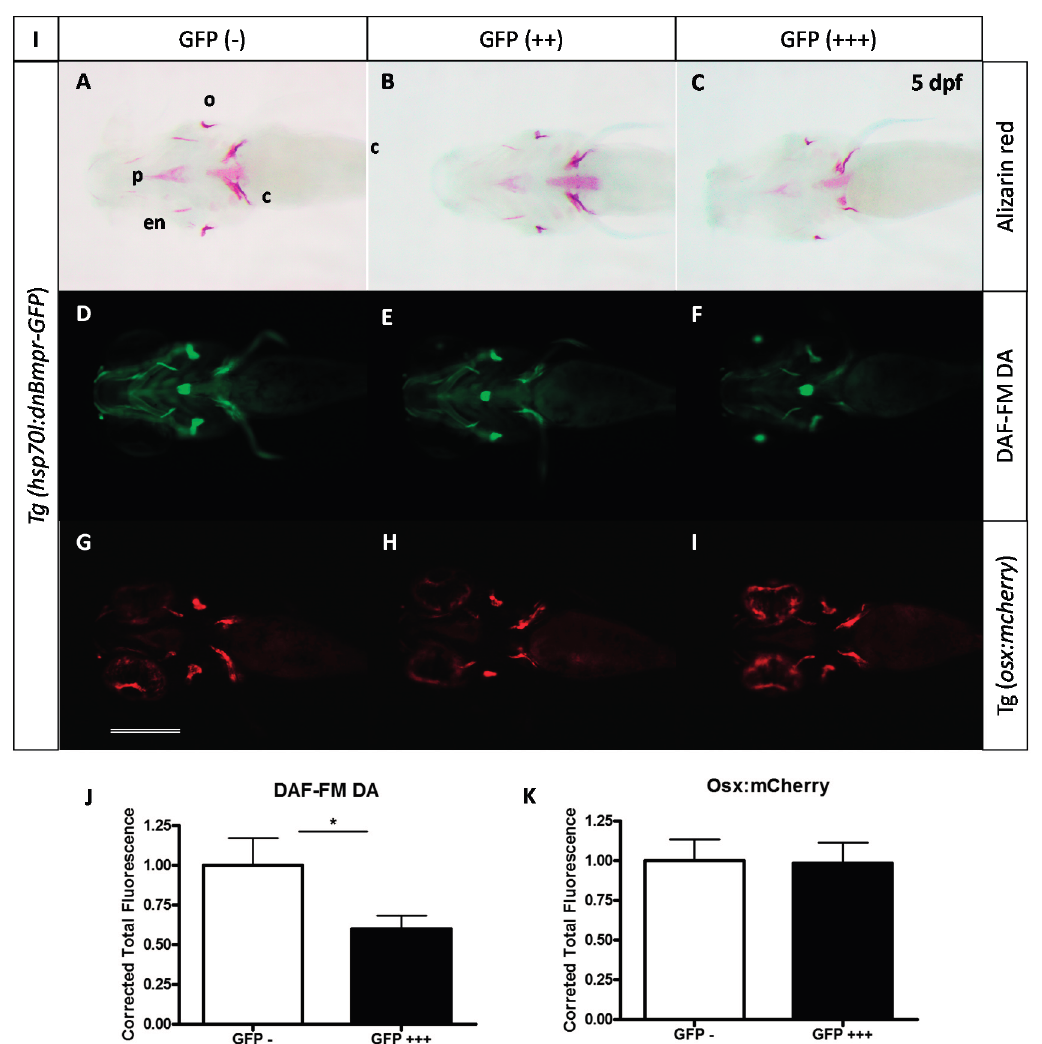
Figure 5. Effects caused by expression of the dominant negative Bmpr on bone formation. ( A – C ) Alizarin red staining of 5 dpf larvae after heat-shock treatment at 2 or 3 dpf. The extent of GFP expression 2 h after treatment indicates the transgenic status of the larva; GFP( − ) being non-transgenic, GFP(++) transgenic, GFP(+++) being homozygous transgenic or larvae highly expressing the transgene ( dnBmpr-GFP) ; ( D – F ) DAF-FM DA staining for nitric oxide detection in 5 dpf larvae (note that GFP fluorescence has disappeared at this time); ( G – I ) Red fluorescence allowing detection of mCherry-expressing osteoblasts c: cleithrum; en: entopterygoid; o: operculum; p: parasphenoid. Scale bar: 200